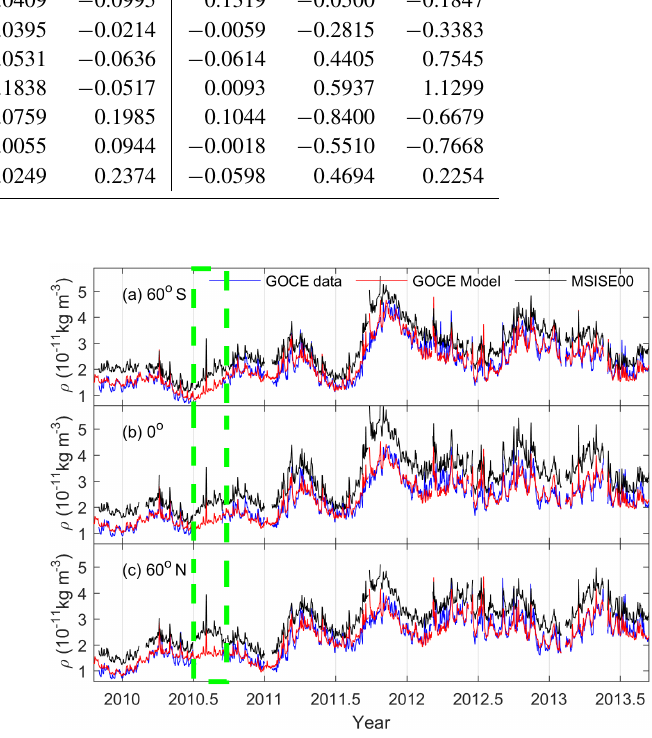
Figure 3. The daily thermospheric mass density normalized to 270km at dawn LST from GOCE data (blue line), and the cor- responding results of our GOCE model (red line) and MSISE00 model (black line) at (a) 60 ◦ S, (b) 0 ◦ and (c) 60 ◦ N during 2009– 2013. The dashed box (green line) shows the predicted mass density from our GOCE density model when the GOCE observations were not